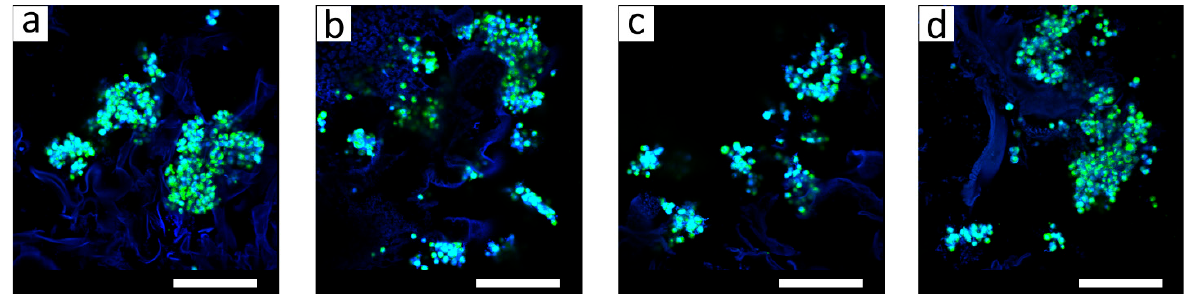
Figure 6. CLSM images of the hyaluronic acid/chitosan hydrogel samples with the L929 cells after cultivation for 1 week. The Hyal/Ch sample was without hydroxyapatite nanoparticles ( a ); the Hyal/Ch/nHAp-1 ( b ), Hyal/Ch/nHAp-5 ( c ) and Hyal/Ch/nHAp-10 ( d ) samples were loaded with 1,